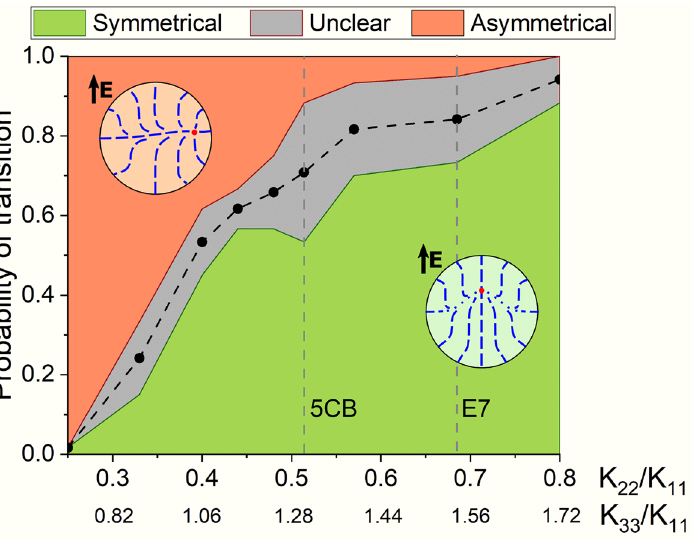
Figure 5. Probabilities of symmetric (green), asymmetric (red), and unclear (grey) transitions at relative droplet helicity parameter N 0 = 2.5 and various elastic constants, calculated from 150 computer simulation runs per point. The black dashed line shows the middle of the “unclear” zone, which estimates experimentally observable